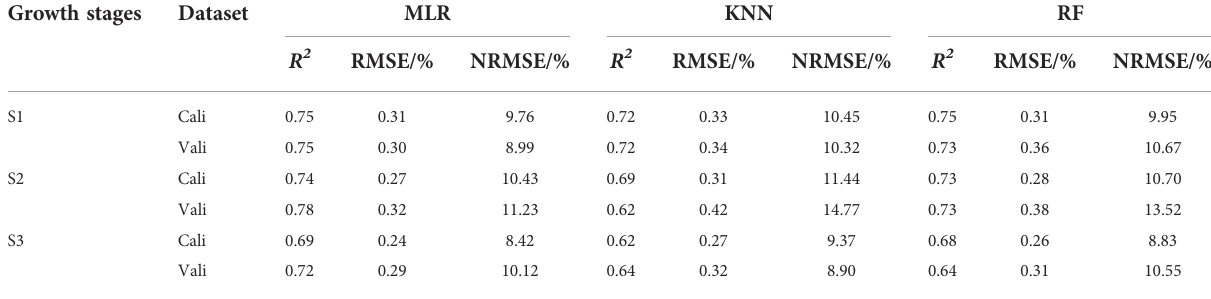
TABLE 3 Visible light vegetation indices estimation of potato